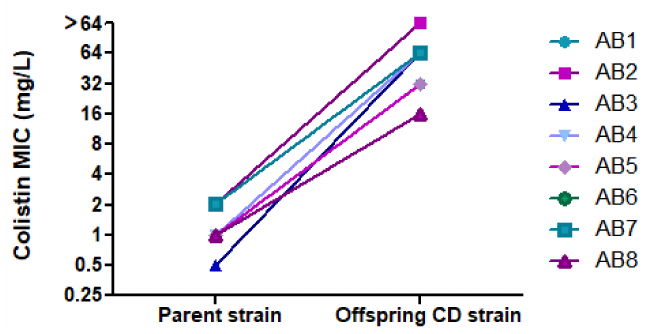
Figure 4. Change in colistin MIC between parent strains and their offspring CD strains. Table 2. Antibiotic resistance profiles. Inhibition zones (mm) by disk diffusion of parent (P), colistin- dependent (CD), and colistin resistant-colistin dependent (CR-CD) strains.